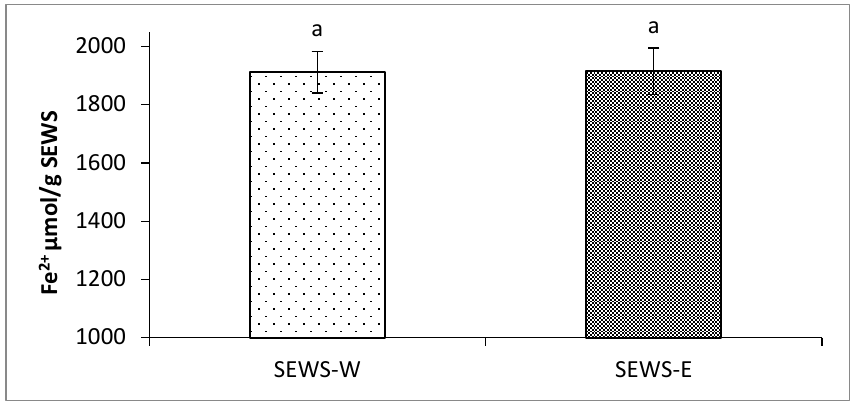
Figure 2. Ferric Reducing Antioxidant Power (FRAP) of sunflower meal ethanol-wash solute. a Means do not differ significantly ( p > 0.05).